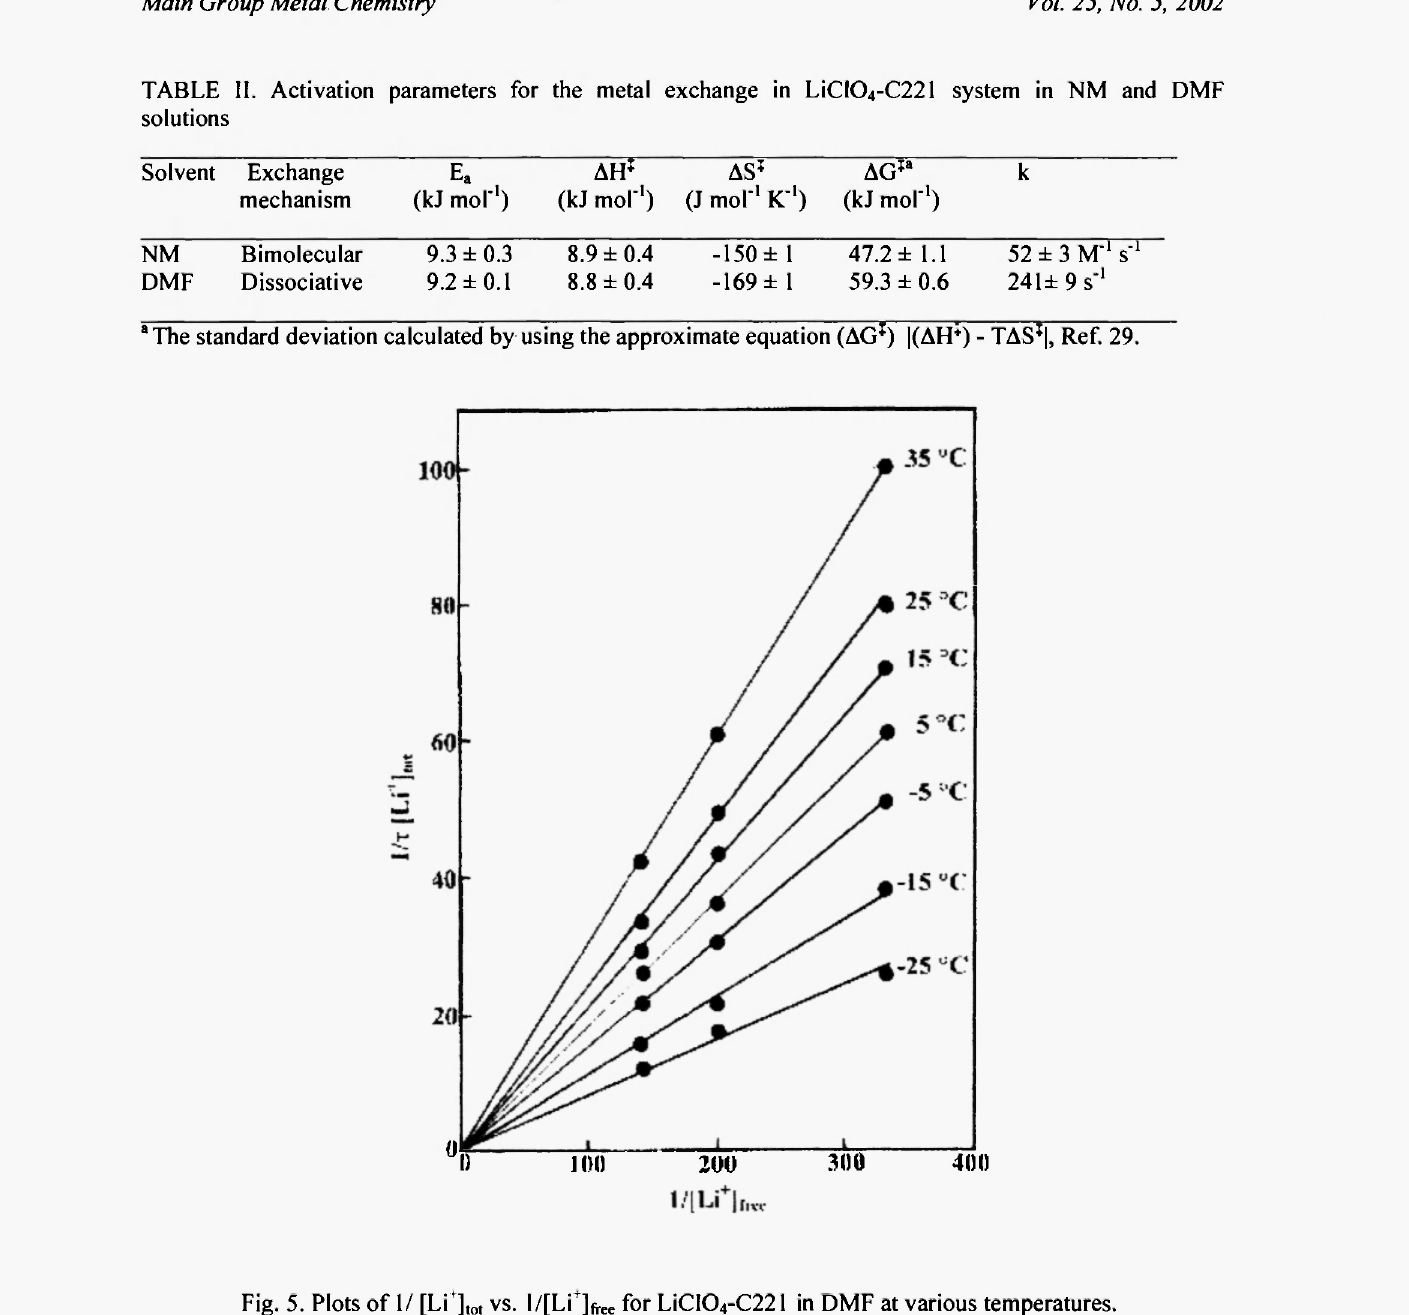
TABLE II. Activation parameters for the metal exchange in LiCI0 4 -C221 system in NM and DMF